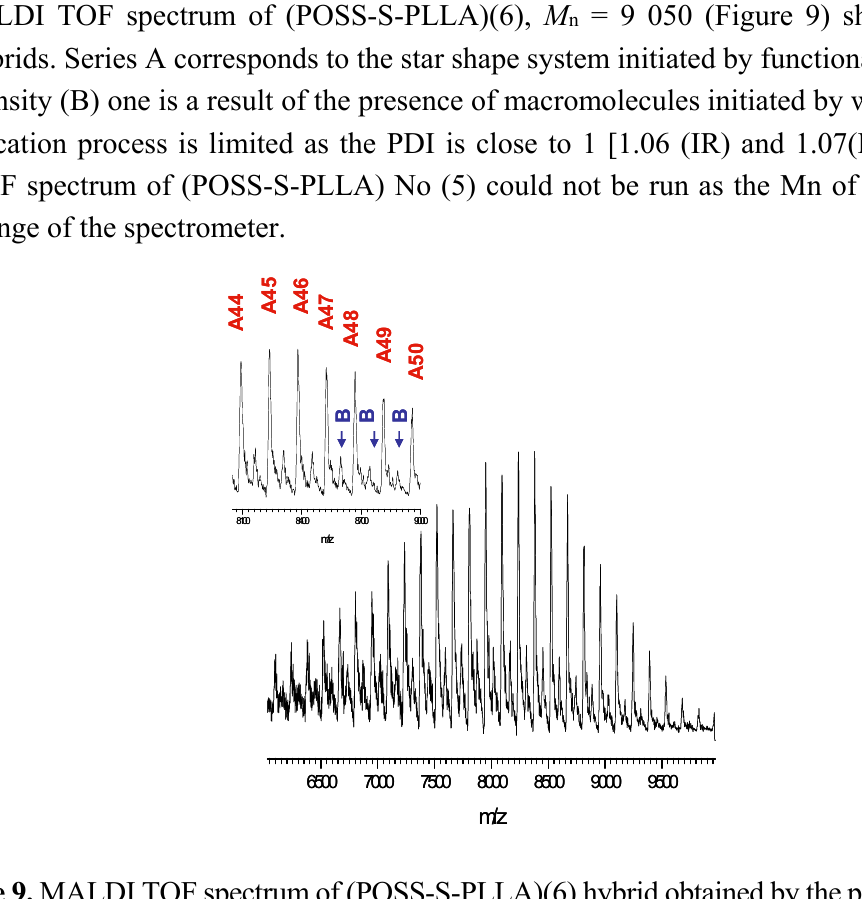
Figure 9. MALDI TOF spectrum of (POSS-S-PLLA)(6) hybrid obtained by the polymerization of L,L -dilactide from (POSS-S-OH) catalyzed by tin (II) 2-ethylhexanoate(2), M n = 9050, PDI =